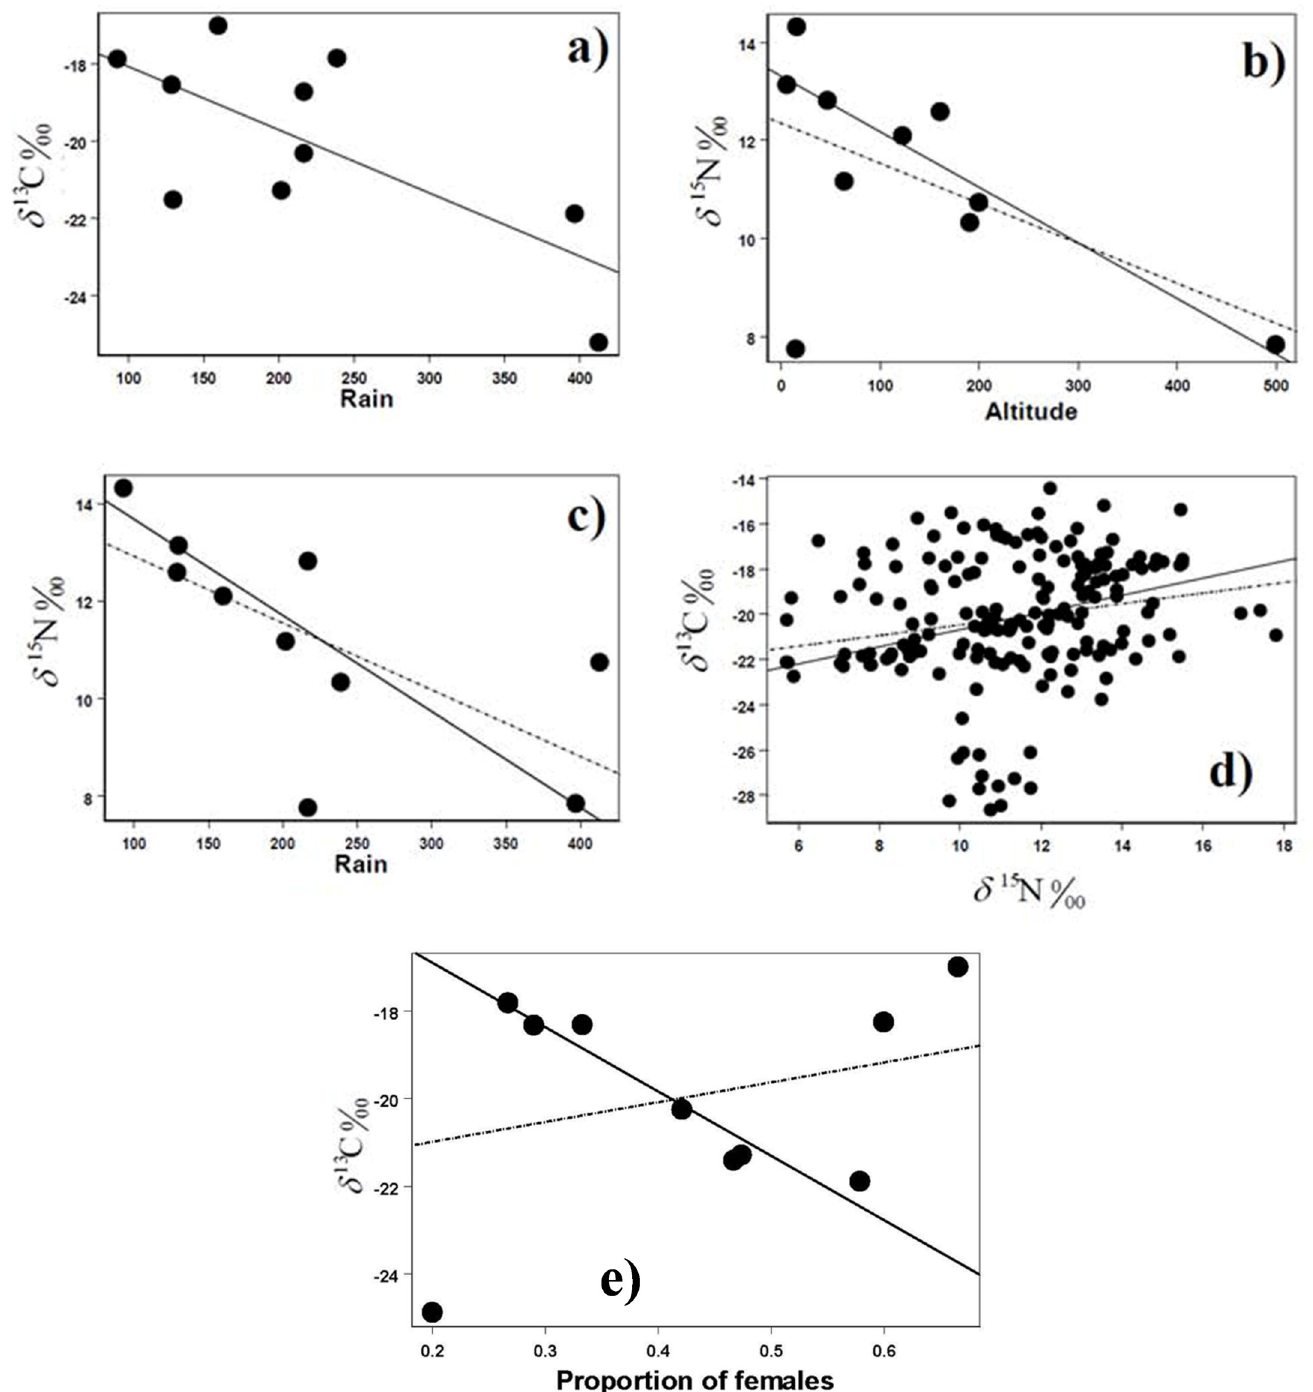
Fig 3. Relationships between isotopic values and several variables across the ten sampled localities in southern Baja California (Mexico). (A) Negative relationship between average values of δ 13 C (a) or δ 15 N (C) in whiptail tissues and the estimated annual rainfall (B) Negative relationship between average δ 15 N values and local altitude. (D) Positive relationship of δ 13 C and δ 15 N values across individual lizards (n = 180). Note that robust regression (continuous line) often differs somewhat from least-squares regression (dotted line). The arrows in charts b and c point to TECO sampling site. (E) Negative relationship between average values of δ 13 C in whiptail tissues and the proportion of females in the ten sampled localities. Note that robust regression (continuous line) has even different sign (i.e. negative) than that estimated by standard least-squares regression (i.e. positive; dotted line).